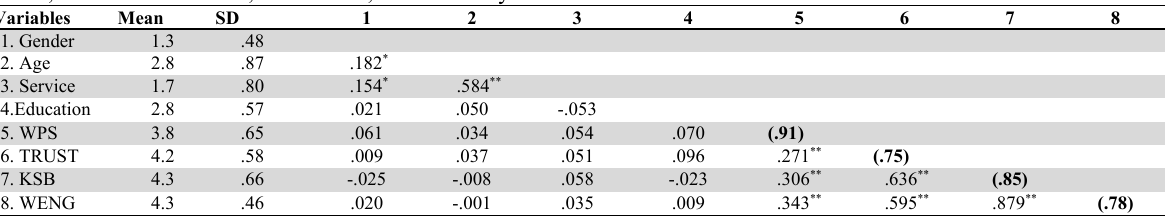
*. Correlation is significant at the 0.05 level (2-tailed), & **. Correlation is significant at the 0.01 level (2-tailed).